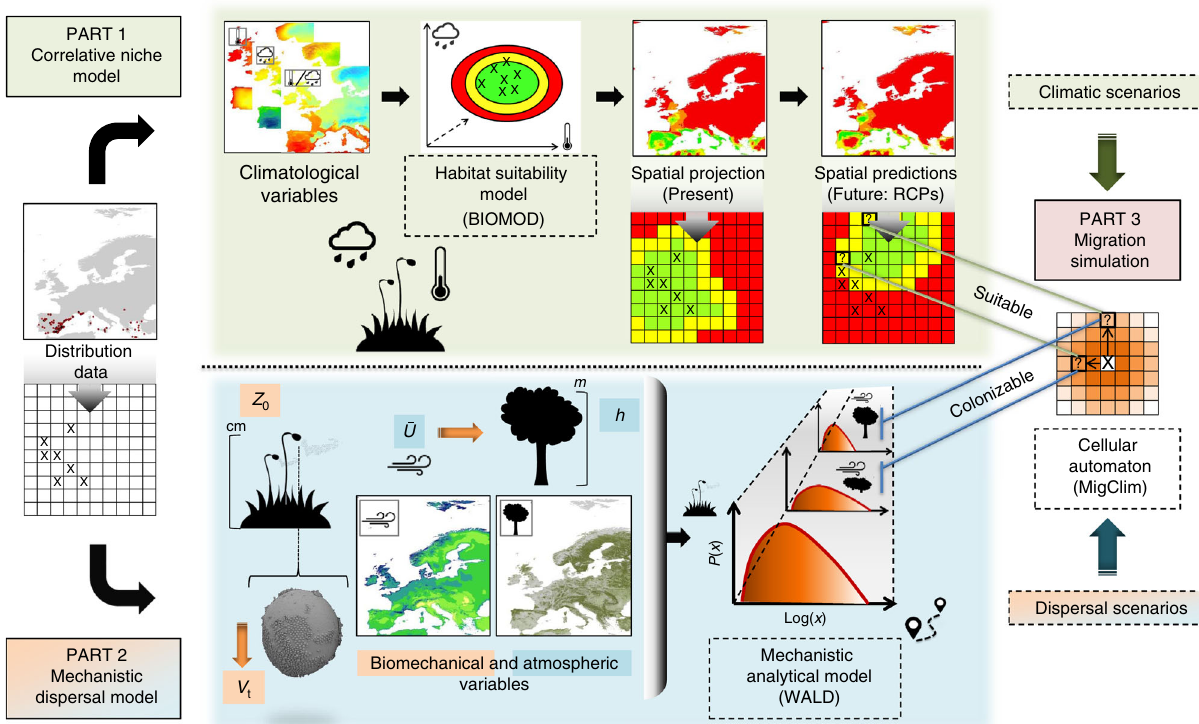
Fig. 4 Overview of work fl ow implemented in the present study to integrate mechanistic dispersal kernels and correlative climatic suitability models in simulations of future wind-dispersed species distributions under climate change. Species distribution data (left) are combined with climatic variables to produce climatic suitability models that are calibrated under present and projected under future climatic conditions (Part 1) and used to build mechanistic dispersal models (Part 2). The latter combine species intrinsic features (spore settling velocity V t and release height Z 0 ) and extrinsic environmental features (mean horizontal wind speed Ū and canopy height h ) to generate maps of spatially explicit dispersal kernels. Climatic suitability and dispersal kernel maps, updated at regular intervals, are fi nally combined to parameterize simulations of dynamic range shifts under changing climatic conditions (Part